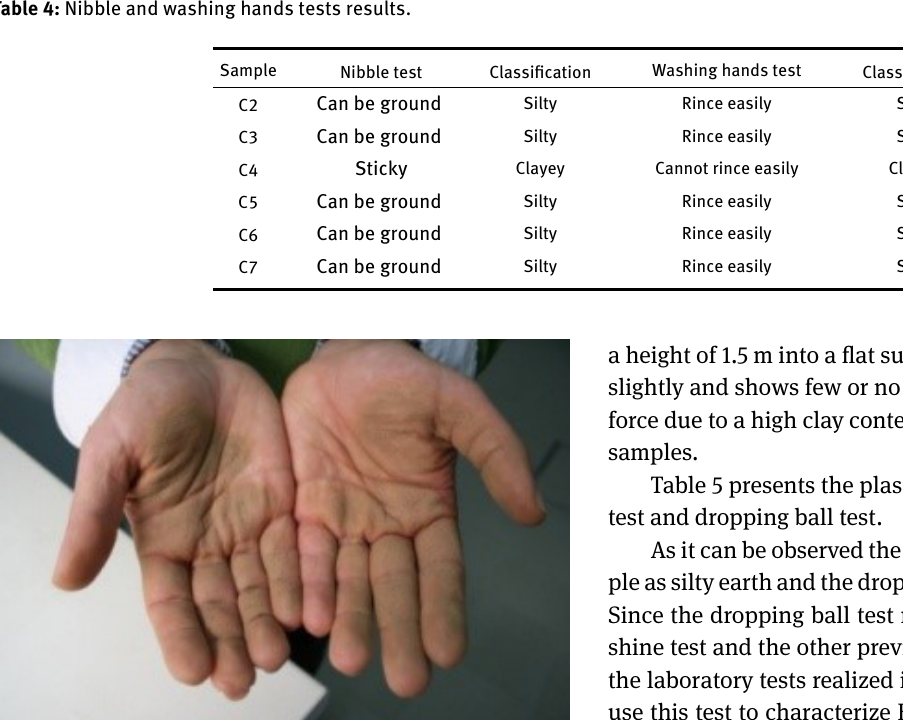
For the shine test, the EBM balls are cut in half with a knife and the cross section of the ball is observed. A shine cross section indicates clay content, a dull cross section indicates higher silt or sand content, (Figure 7-a)). In the droppingballtest, (Figure7-b)),theballs